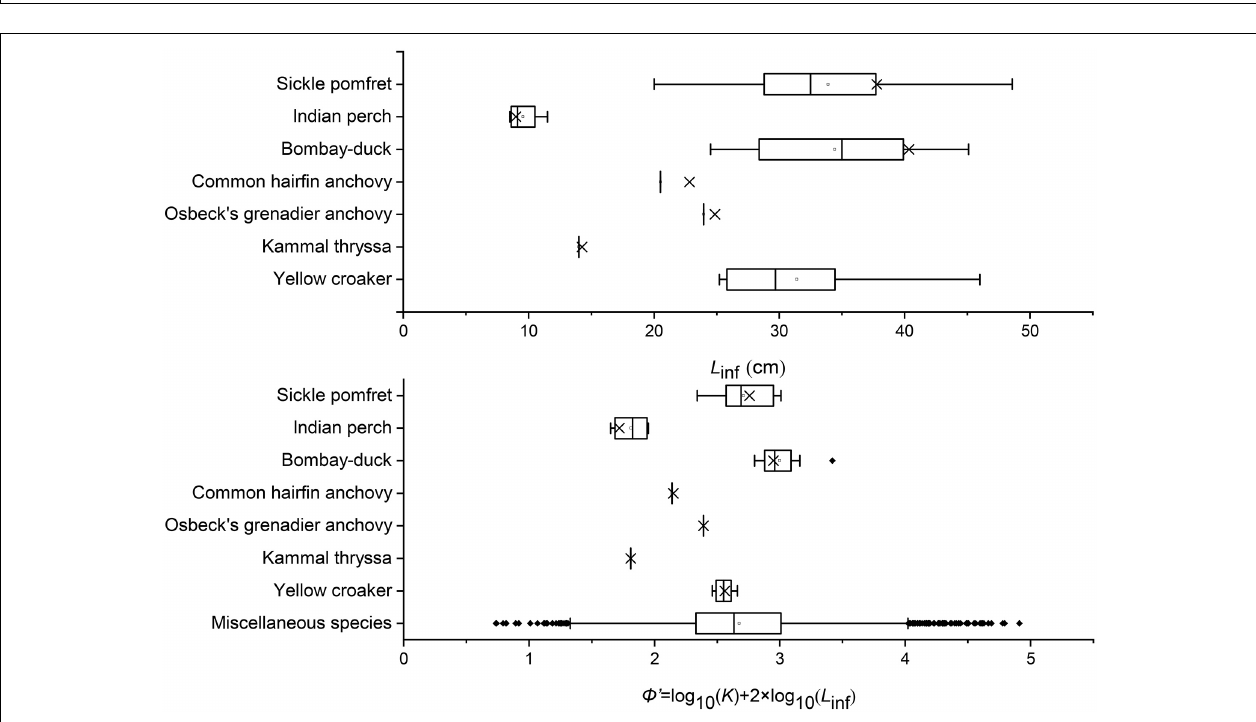
FIGURE 6 | (A) The L inf (cm, total length) estimated by LBB for six fish species [cross; the L inf value of yellow croaker from LBB was not shown because of its unsuitable standard length (SL) and the lack of length–length correlation coefficients]. The box plots depict the records of L inf values collected from FishBase with mean values depicted by tiny squares. (B) The growth performance index ( (cid:56) (cid:48) ) of the seven fish species in question estimated by the L inf values from LBB (cross). The box plots show the growth performance index ( (cid:56) (cid:48) ) for these fish stocks with data collected from FishBase.